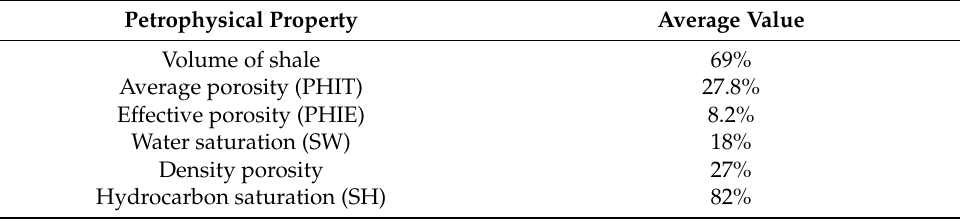
Table 7. Petrophysical properties and their average values.